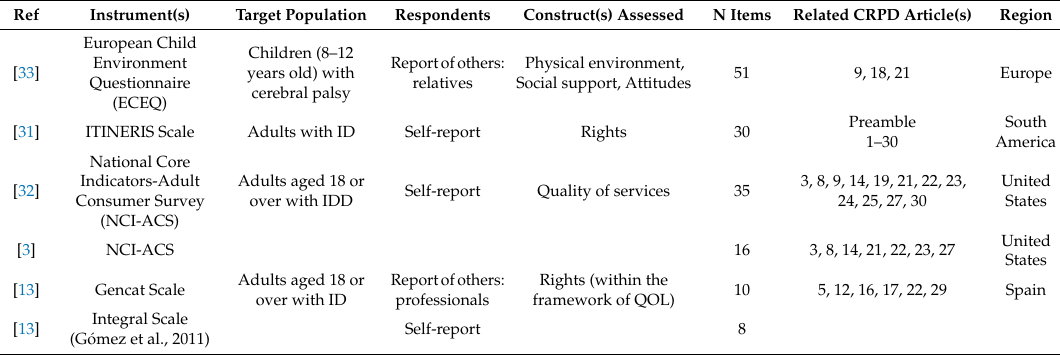
Table 4. Instruments applied or proposed in the studies and their relationship to CRPD Articles and the quality